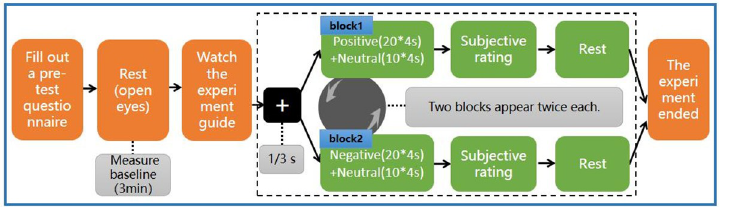
Fig 4. Flowchart of the cognitive psychological experiment. The experiment consists of the emotion task and subjective rating. There were 2 blocks in the experiment. Each block contained 30 trials, and the trial order was random. After the image disappeared, the subjective rating of the image was entered via the